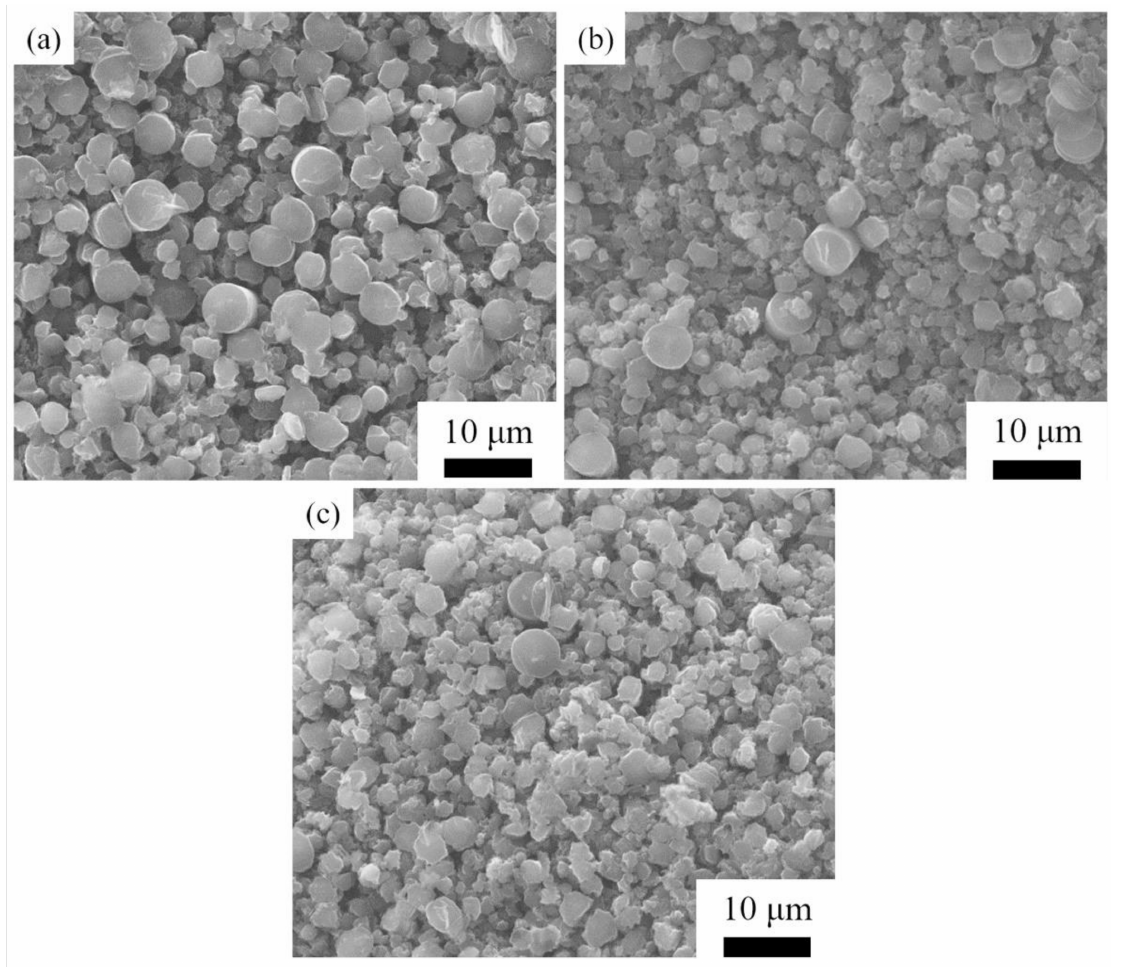
Figure 6. The morphology of SiC grains prepared by HTPVT at 2150 ◦ C for 10 min: ( a ) 2000 Pa; ( b ) 3000 Pa; ( c ) 4000